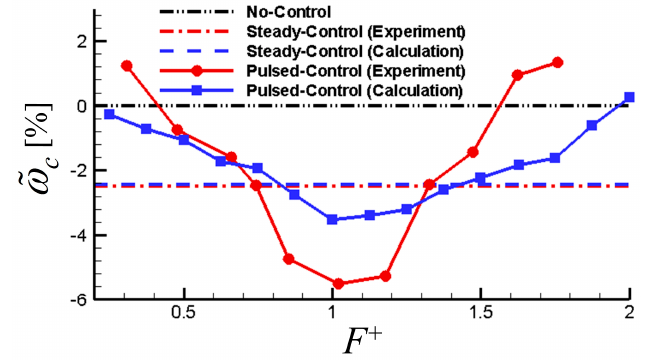
Figure 15. Relative loss coefficient vs. reduced jet frequency (numerical and experimental results).